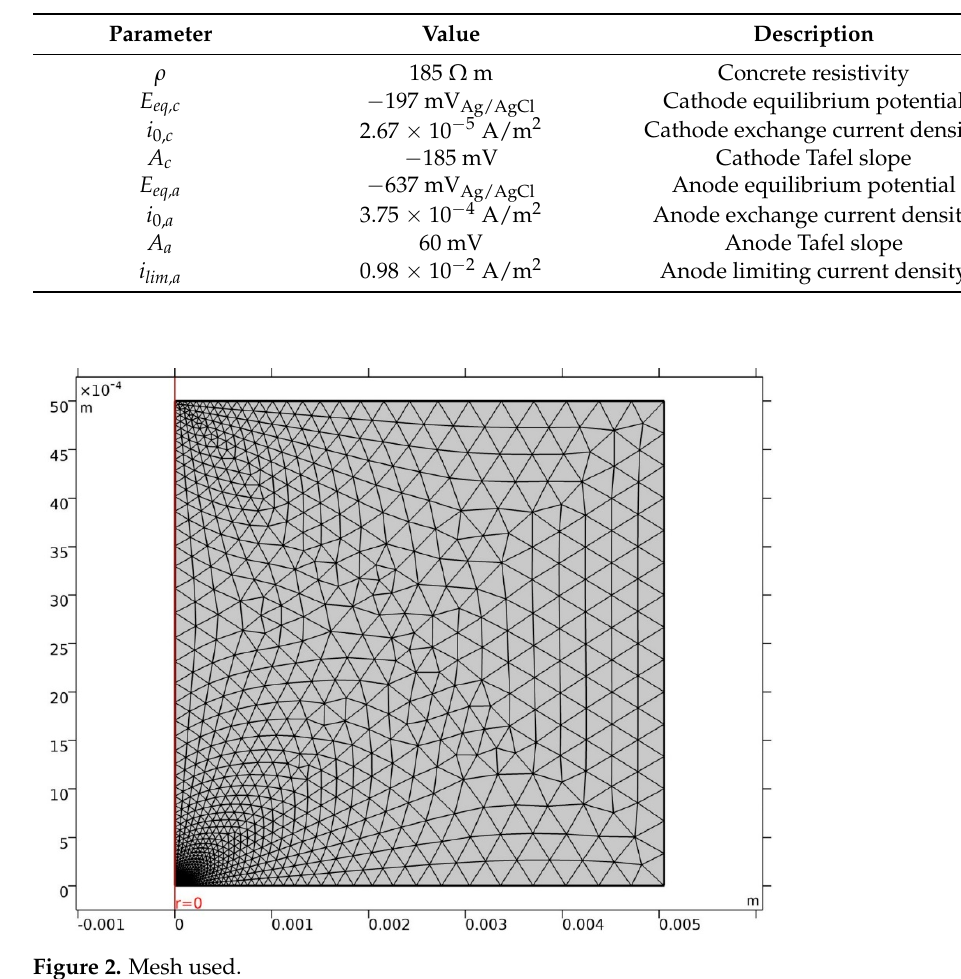
Table 1. Summary of Tafel slopes and current densities found in the literature.